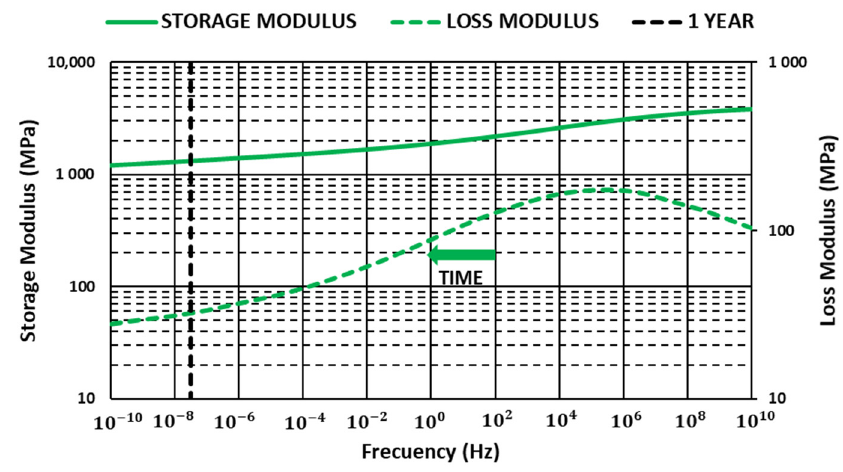
Figure 7. Variation in the storage and loss modulus with time PBT G20 (T = 56.3 ◦ C).